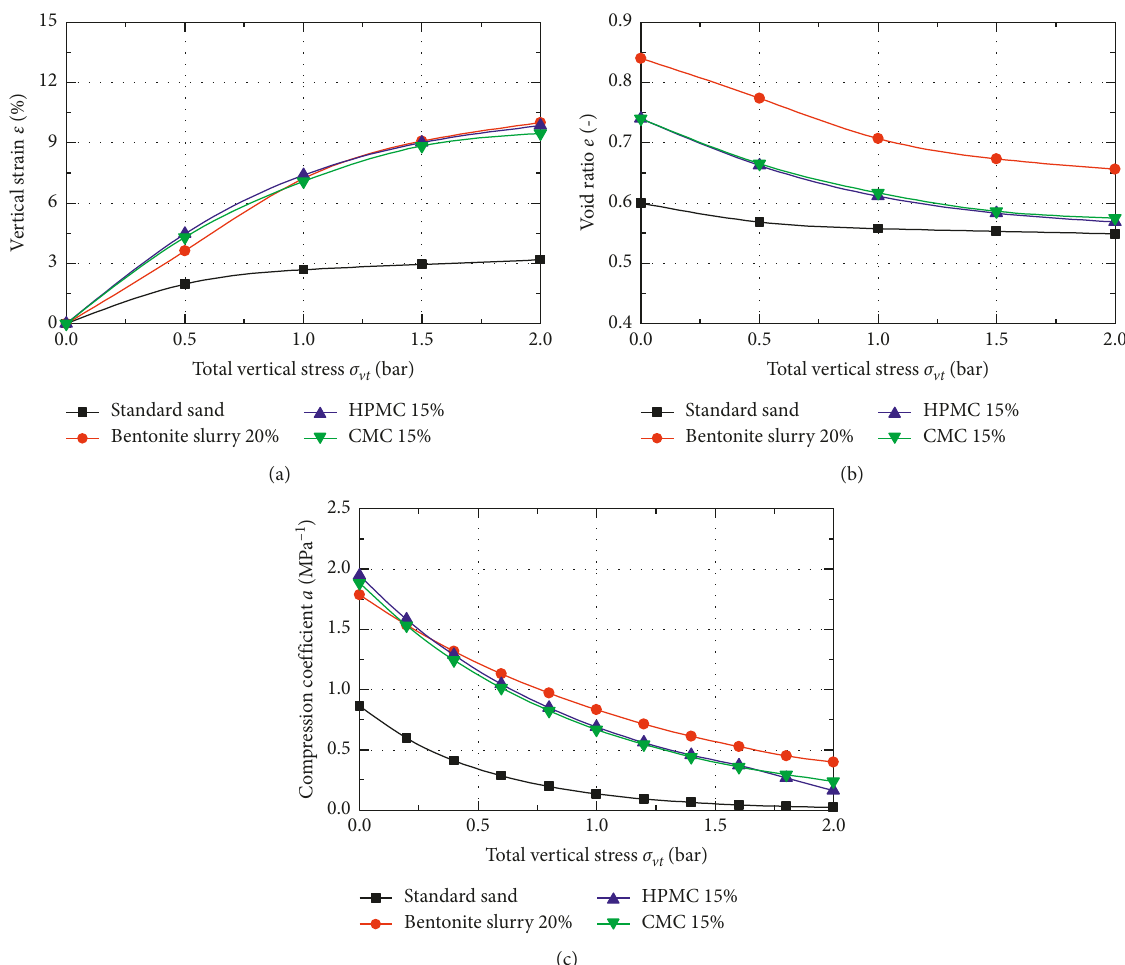
Figure 7: Compression results of the liquid material conditioned sand. Vertical strain ε (a), void ratio e (b), and compression coefficient a (c) plotted vs. the total vertical stress σ vt